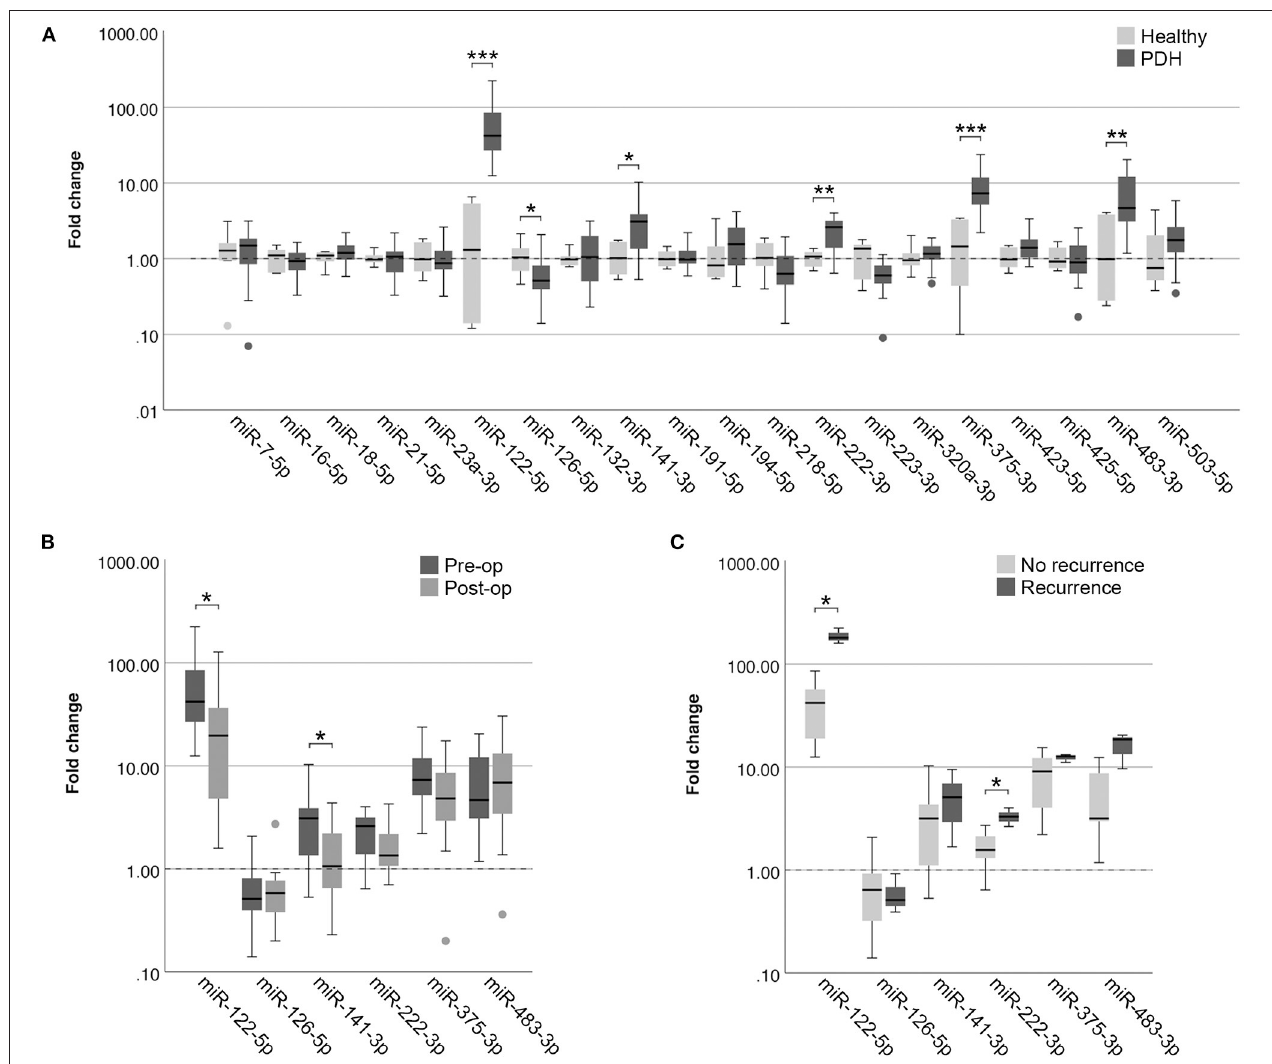
FIGURE 2 | Circulating miRNA expression levels in EDTA plasma samples, normalized with V min (12 most stably expressed miRNAs), in (A) dogs with PDH ( n = 19) and healthy dogs ( n = 6); (B) dogs with PDH ( n = 19) before (pre-op) and after (post-op) hypophysectomy; and (C) dogs with PDH with ( n = 3) or without ( n = 7) recurrence of hypercortisolism within a year after hypophysectomy. Circles above and below boxes indicate outliers. * p < 0.05; ** p < 0.01; *** p < 0.001. PDH, pituitary-dependent